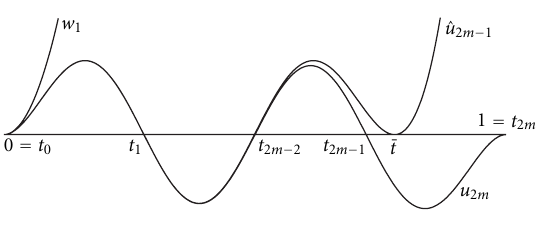
Figure 3.3. Proof of Lemma 3.5 for m =